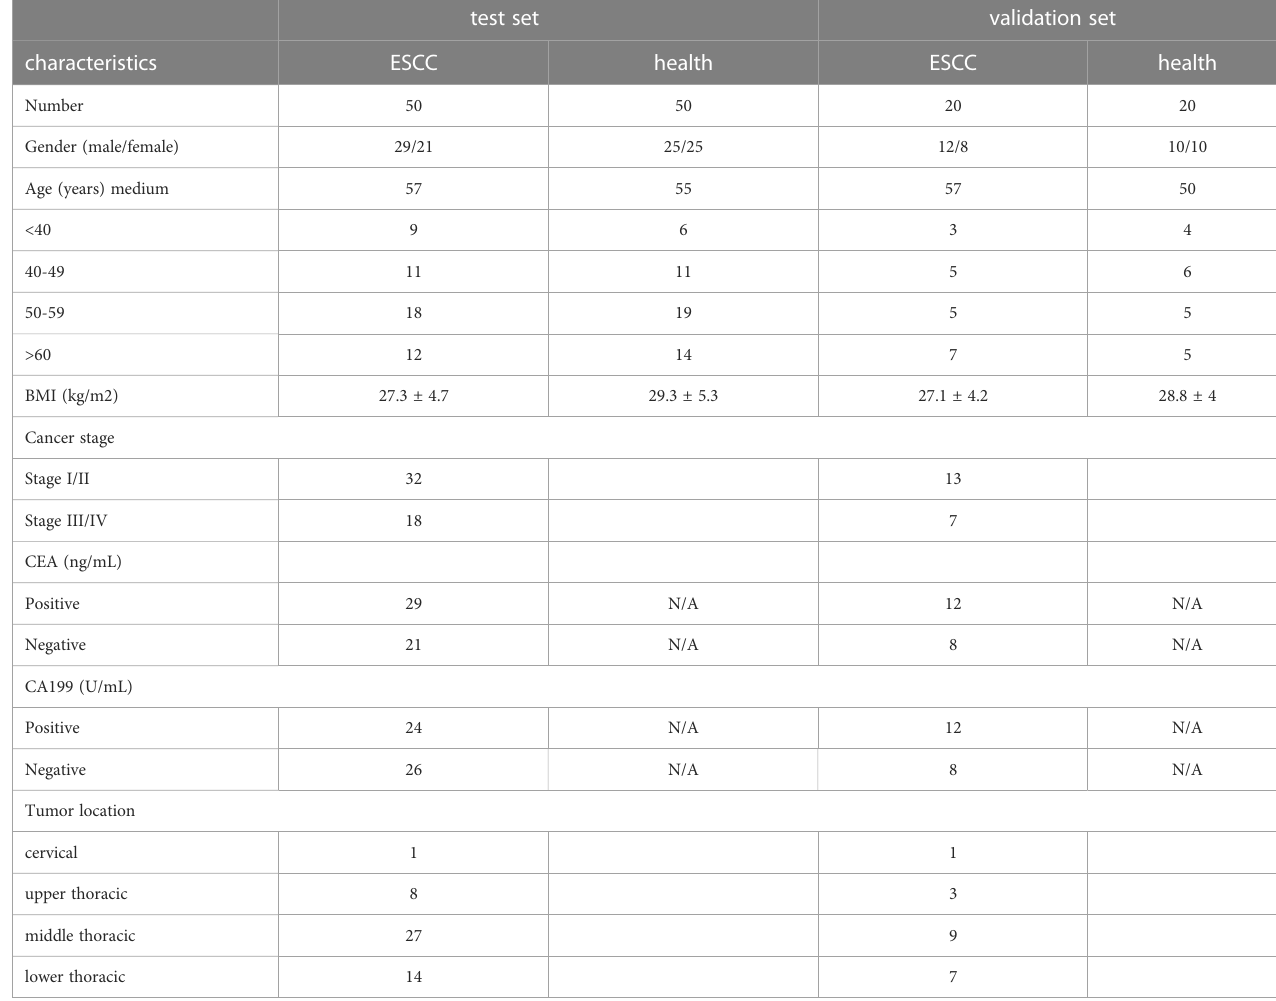
TABLE 1 Summary of the clinical and demographic characteristics of the study subjects.